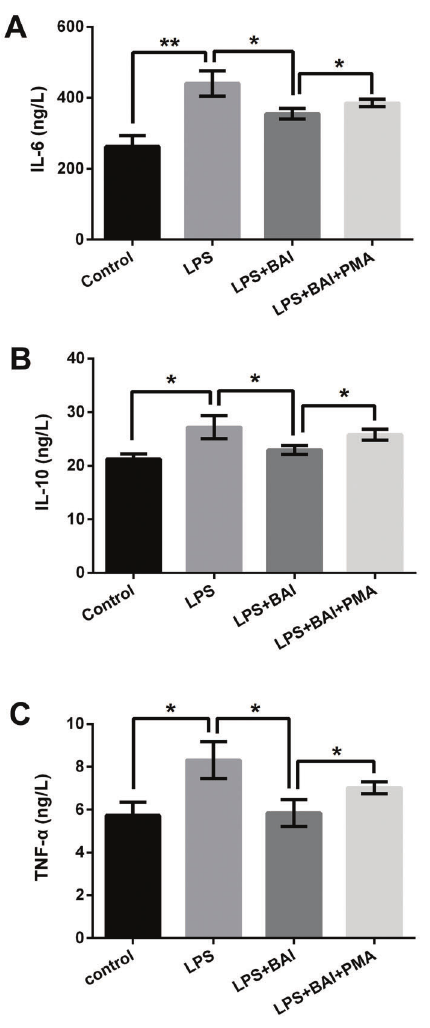
Figure 5. A , PMA alleviated the effects of BAI on LPS-induced IL-6 expression; B , IL-10 expression; and C , TNF- a expression in RPTECs. BAI: baicalein; LPS: lipopolysaccharide; RPTECs: renal proximal tubular epithelial cells; NF- k B: nuclear factor kappa B; PMA: phorbol ester; IL-6: interleukin-6; IL-10: interleukin-10; TNF- a : tumor necrosis factor- a . Data are reported as means ± SE. *P o 0.05; **P o 0.01